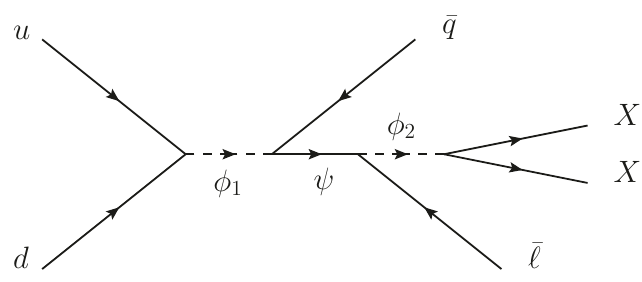
Figure 4 . Example of tree level diagram contributing to the matching condition of eq. (4.8) which arises from the UV model of Lagrangian